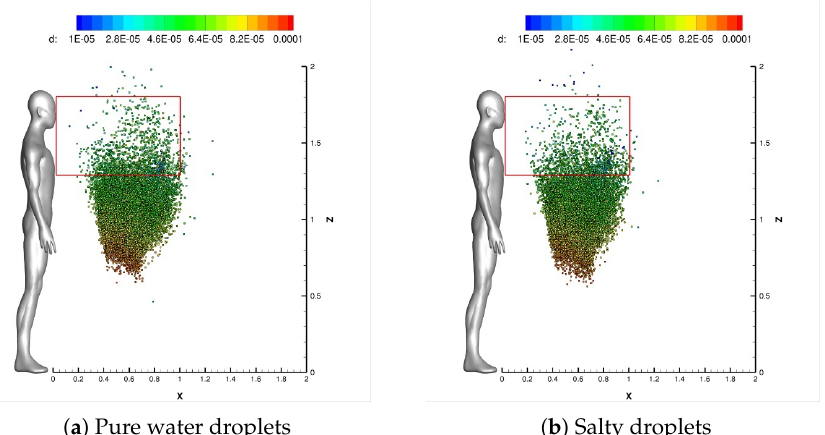
Figure 3. Cloud representation at t = 4 s. Parcels are colored with the particle diameter.